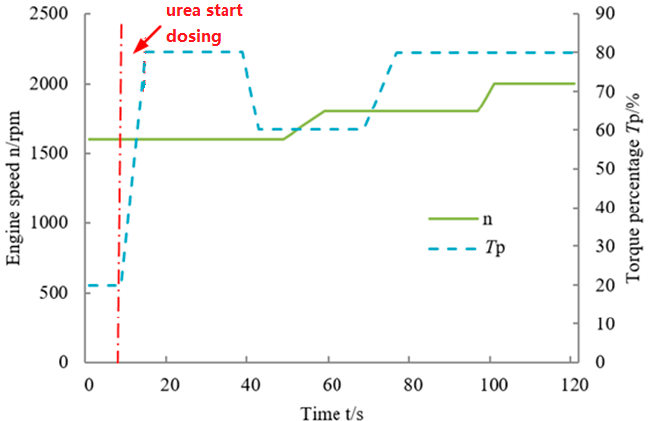
Figure 3. Low frequency dynamic process.